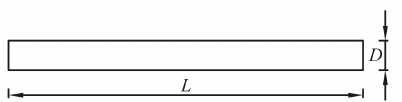
Figure 7. Free vibration analysis of a slender rod. Geometric and mechanical parameters used in this example are L = 100, thickness t = 1, D = 1, Poisson’s ratio v = 0, Young’s modulus E = 72 × 10 9 , mass density ρ = 2700. Since